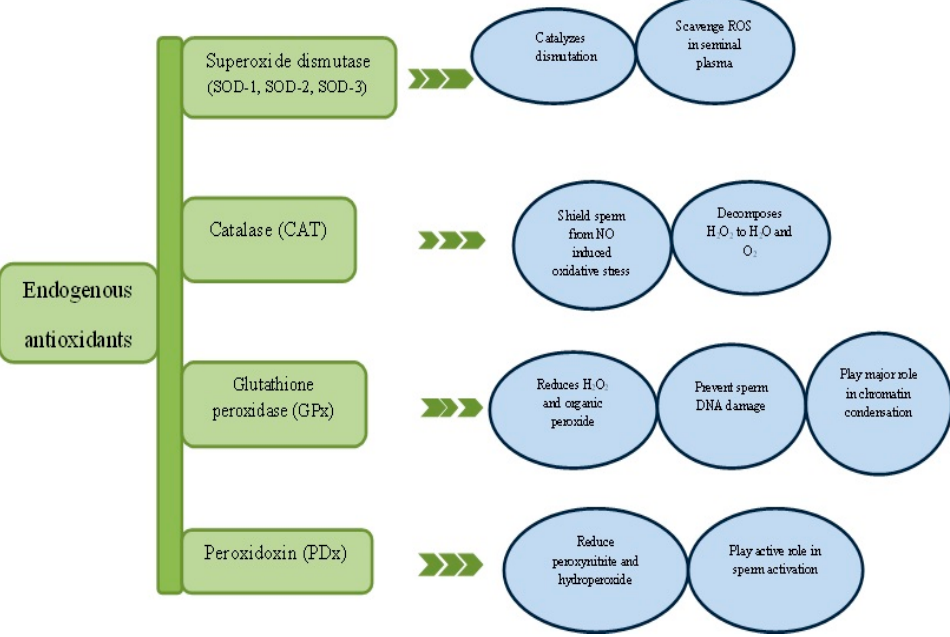
Figure 2. Critical role of antioxidant enzymes in spermatogenesis. ROS—Reactive oxygen species, NO—Nitric oxide.